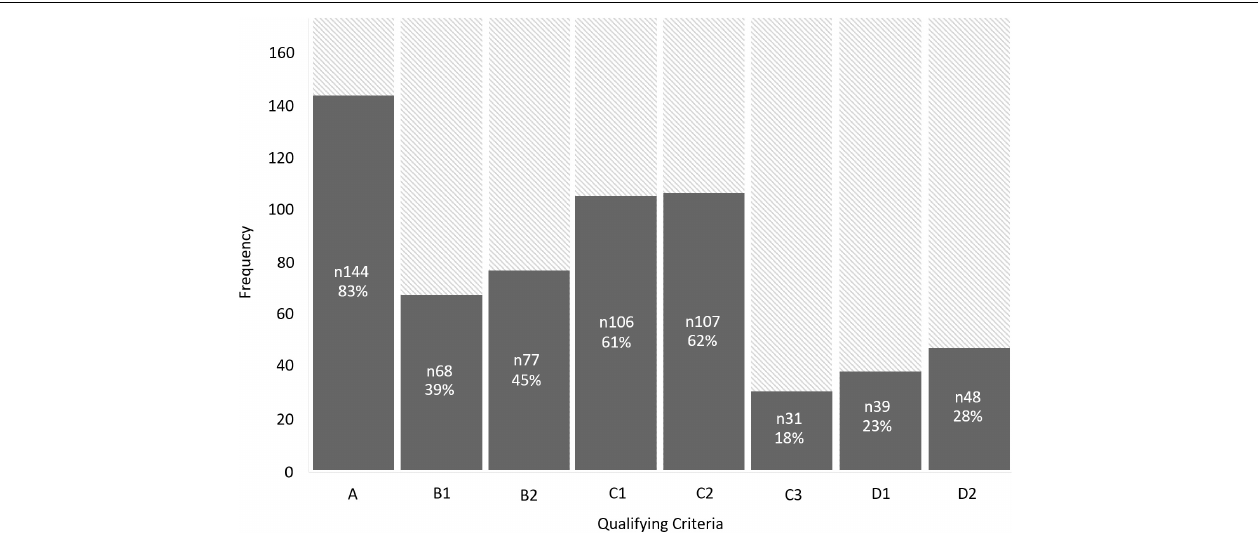
FIGURE 7 | Frequency of IMMA selection criteria and sub-criteria used to identify IMMAs across the network of 173 identified areas (Criterion A: Species or Population Vulnerability; Criterion B: Distribution and Abundance, Sub-criterion B1: Small and Resident Populations, Sub-criterion B2: Aggregations; Criterion C: Key Life Cycle Activities, Sub-criterion C1: Reproductive Areas, Sub-criterion C2: Feeding Areas, Sub-criterion C3: Migration Routes; Criterion D: Special Attributes, Sub-criterion D1: Distinctiveness, Sub-criterion D2: